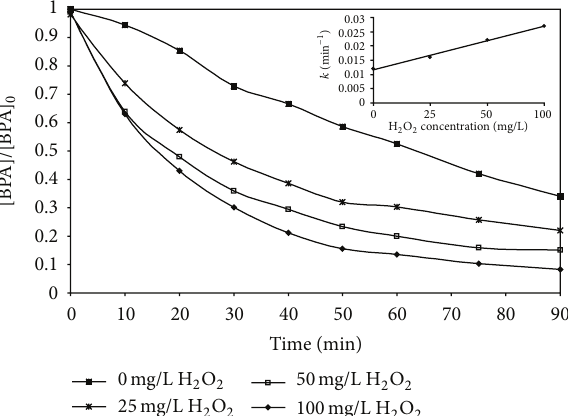
Figure 8: Effect of H 2 O 2 on the conversion of 100 𝜇 g/L BPA in UPW at 1.6 mg/cm 2 ZnO. Inset graph: change of 𝑘 concentration.